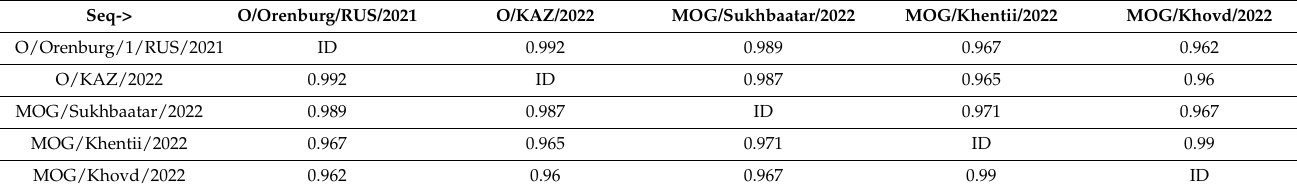
Table 1. Nucleotide identities of the isolates in this